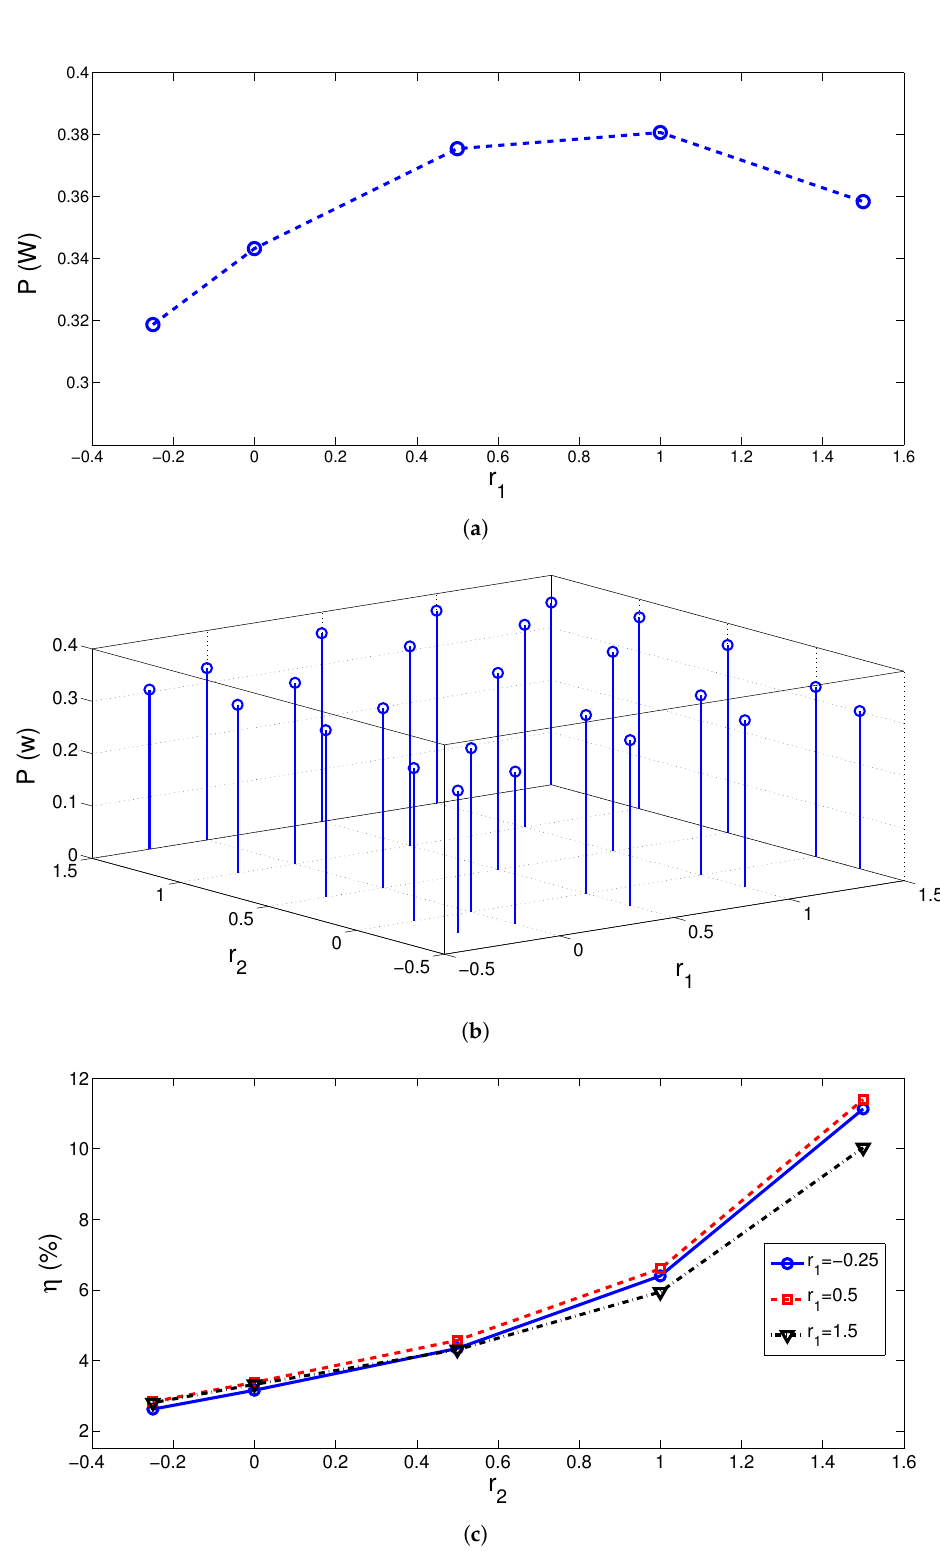
Figure 11. Generated powers ( a , b ) and efficiency ( c ) variation of the TEG device with respect to changes in the jet inlet horizontal location combinations ((Re 1 , Re 2 ) = (500, 500), z h = 3w s , φ =